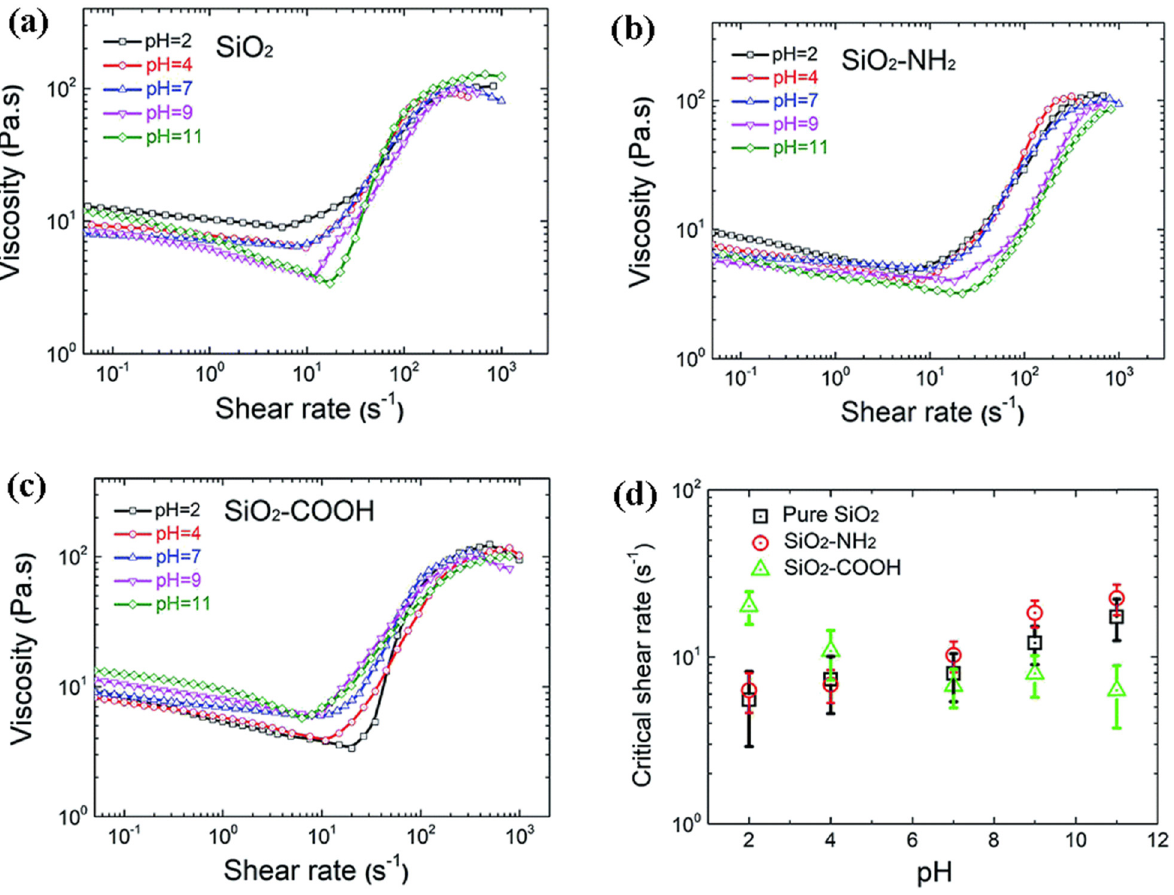
Figure 21: Viscosity curves of three suspensions at di ff erent pH values and critical shear rates: ( a ) SiO 2 suspension, ( b ) SiO 2 – H 2 sus - pension, ( c ) SiO 2 – COOH suspension, and ( d ) critical shear rate of the suspension [ 125 ] ; Copyright: 2019 with permission from RSC